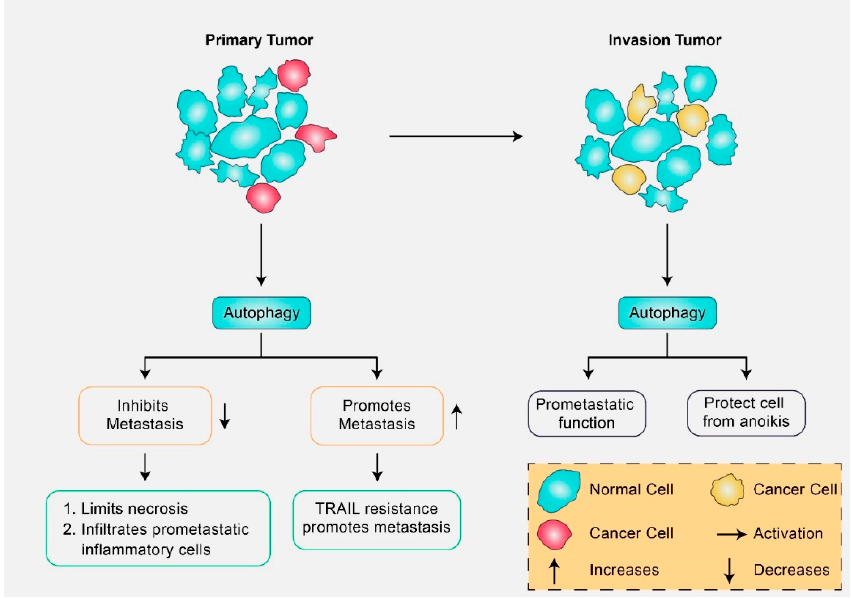
Figure 2. In cancer cells, autophagy exhibits a dual role in metastasis and invasion. Depending on the stage and type of tumor cell, autophagy can prevent or stimulate cancer cell maintenance. In the early stages of autophagy in primary tumors, metastasis has been suppressed via anti-metastatic elements in addition to stimulation of tumor conservation along with progression by inducing cellular resistance against TRAIL, a tumor necrosis factor-related apoptosis-inducing ligand, to induce apoptosis. Later, in the course of invasion, tumor cells spread and enter lymphatic or blood vessels. Here, autophagy shows a pro-metastatic function through cell protection from anoikis triggered via extracellular matrix detachment.